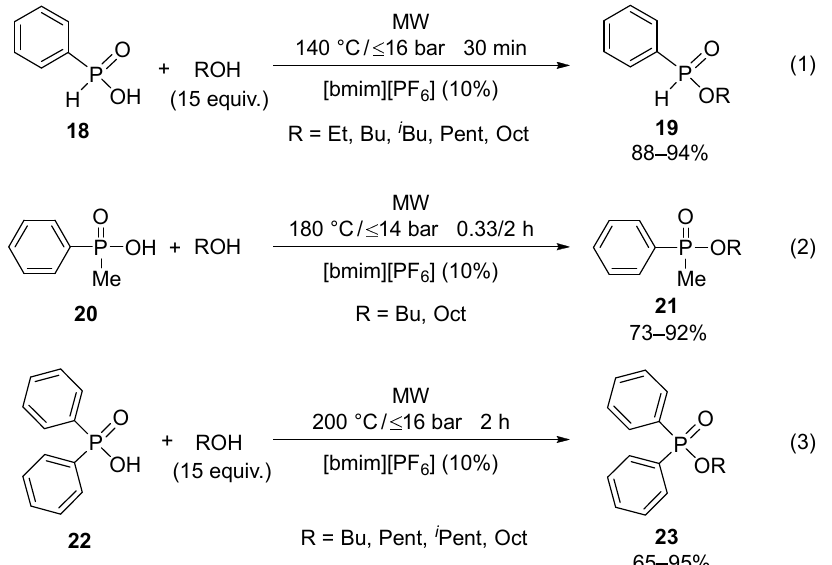
Table 4. MW ‐ promoted direct esterification of phenylphosphonic monoesters ( 27 ).